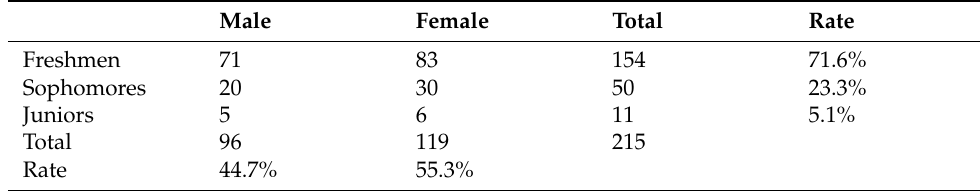
Table 2. Statistics of participants.